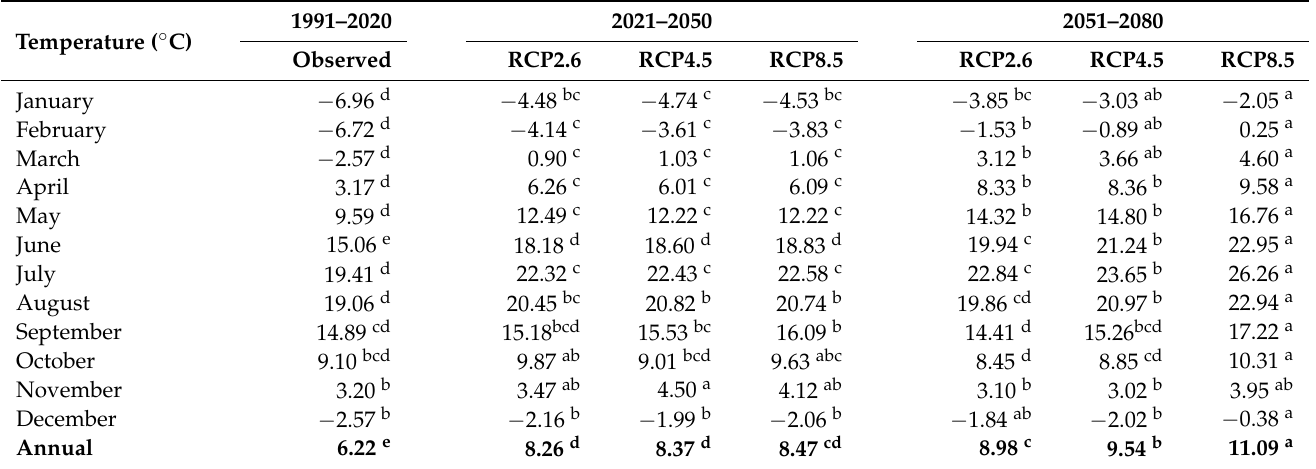
Note: Means that do not share a letter are significantly different at α = 0.05 (95% confidence) as per Tukey’s method. The bolded values represent annual average of all the months and need be